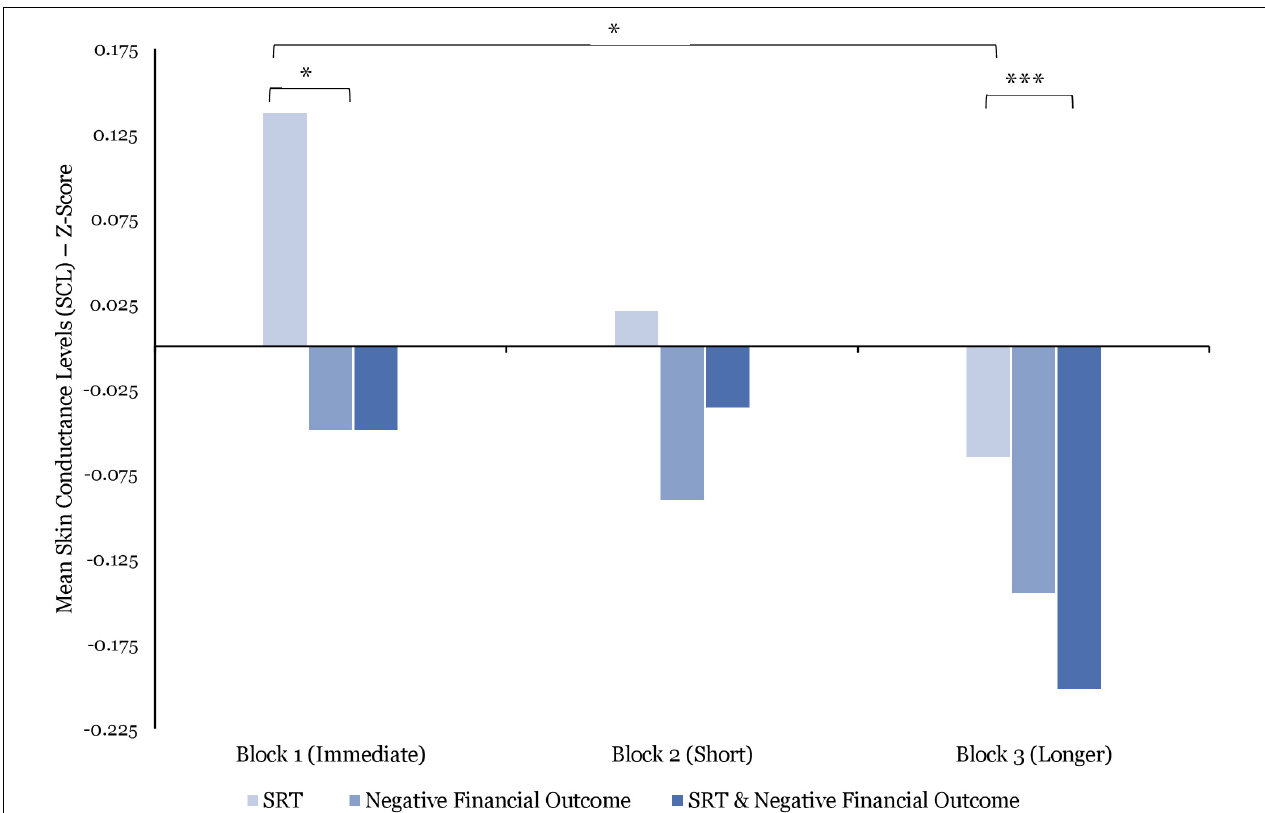
FIGURE 7 | Comparisons of mean skin conductance levels (SCL) (z-score) by stress manipulations and by blocks. Significant differences are marked as ∗ p < 0.05; ∗∗∗ p <